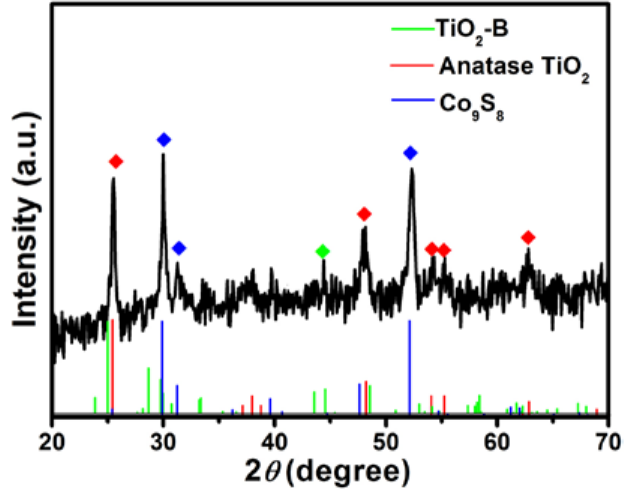
Figure 2. XRD pattern of the TiO 2 nanobelt@Co 9 S 8 composites.